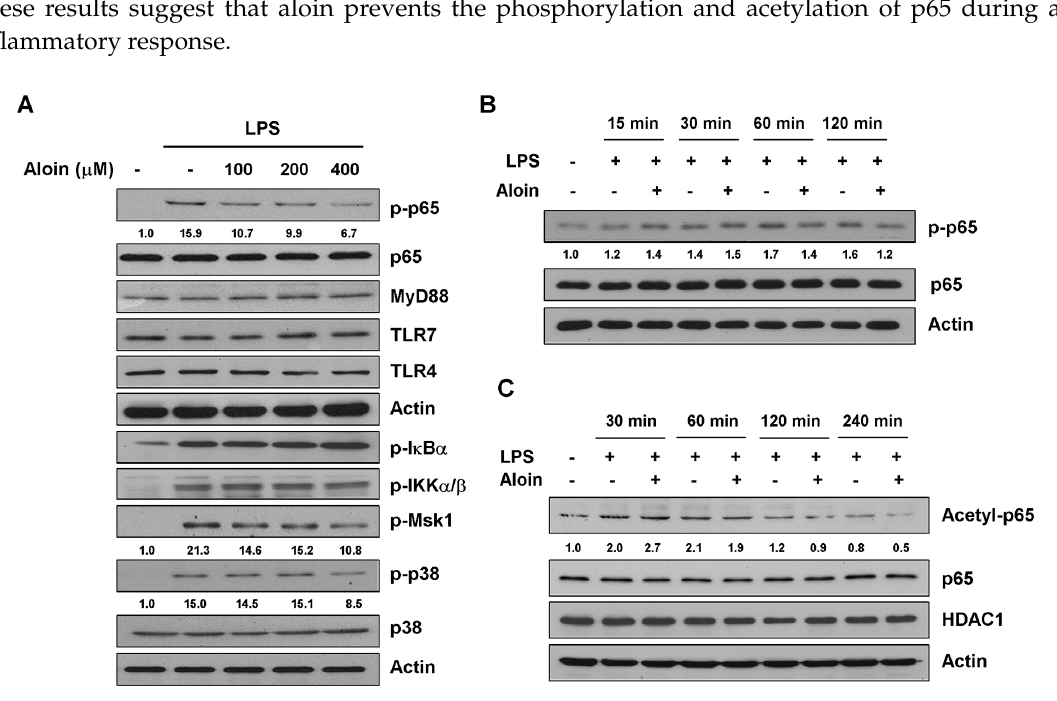
Figure 4. Aloin inhibits LPS-induced NF- κ B p65 phosphorylation and acetylation. ( A ) RAW 264.7 cells were pre-treated with various concentrations of aloin for 2 h, and stimulated with LPS (100 ng/mL) for 2 h. The protein expression levels of phospho-p65, total p65, MyD88, TLR4, TLR7, phosphor-I κ B α , phospho-IKK α / β , phospho-Msk1, phospho-p38 and total p38 was determined by Western blotting; ( B ) Cells were pre-treated with or without aloin (400 µ M) for 2 h, and stimulated with LPS (100 ng/mL) for 15 min, 30 min, 60 min, or 120 min. The protein levels of phospho-p65 and total p65 were analyzed by Western blotting; ( C ) Immunoblotting analysis of acetylated p65, total p65, and HDAC1 in RAW 264.7 cells treated with aloin and LPS at indicated time points.